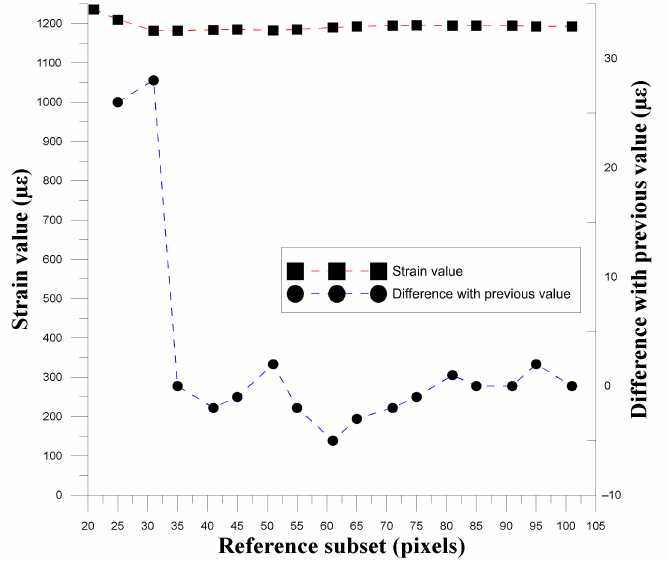
Figure 7. Trend graph of strain variation and strain difference in the third group as the size of the reference subset